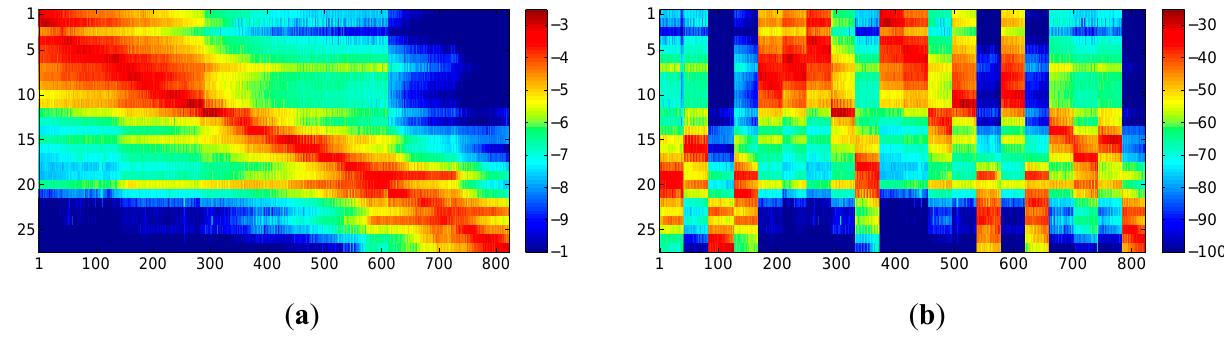
Figure 9. The columns of the radio map are randomly realigned to simulate the scenario that radio map is increased with more interested area for localization requirement.